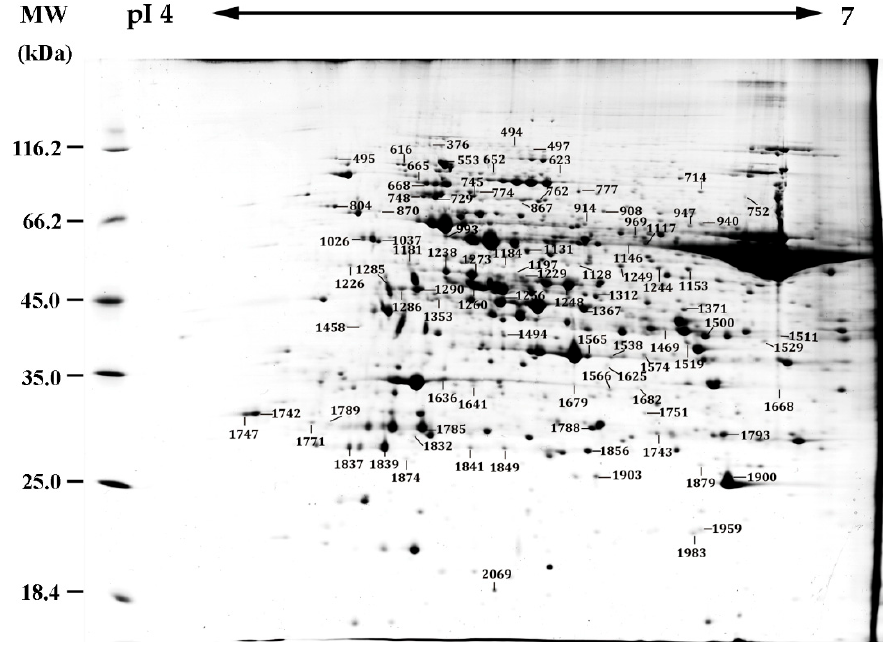
Figure 5. Representative two-dimensional gel electrophoresis (2DE) gel images of proteins in leaves of spinach Sp73. Proteins were separated on 24 cm linear gradient immobilized pH gradient (IPG) strips (pH 4–7) using isoelectric focusing (IEF) in the first dimension, followed by 12.5% sodium dodecyl sulfate polyacrylamide gel electrophoresis (SDS-PAGE) gels in the second dimension. The 2DE gel was stained with Coomassie Brilliant Blue. The molecular weight (MW) in kilodaltons (KDa) and isoelectric point (pI) of proteins are indicated on the left and top of the gel, respectively. A total of 84 heat-responsive proteins identified by matrix-assisted laser desorption/ionization tandem time of flight mass spectrometry (MALDI TOF-TOF MS) were marked with numbers on the gel. Detailed information can be found in Supplementary Figure S1 and Supplementary Table S1.